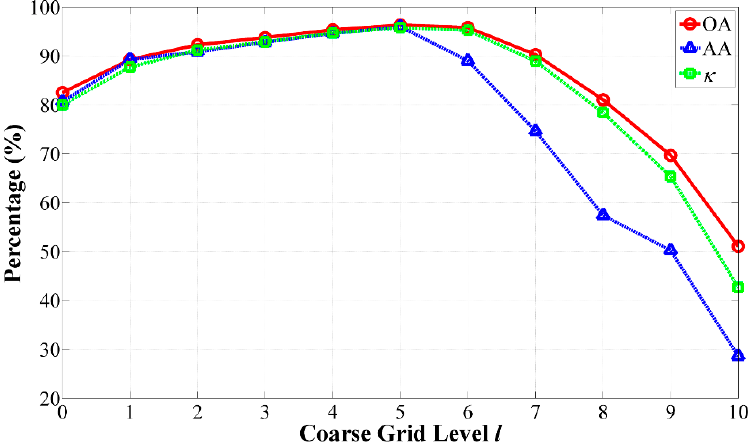
Figure 6. Sensitivity analysis of the GAs using the AMG-M-HSEG method with the Indian Pines image for l from 0 to 10.